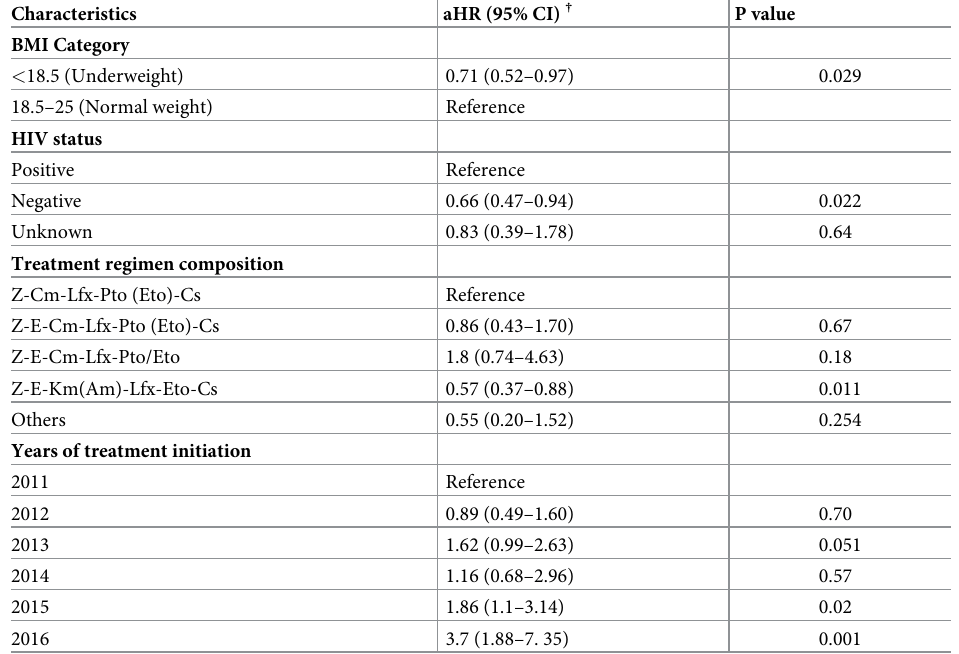
Table 3. Multivariable analysis of predictors of initial sputum culture conversion among multi-drug resistant tuberculosis patients (cid:3) .